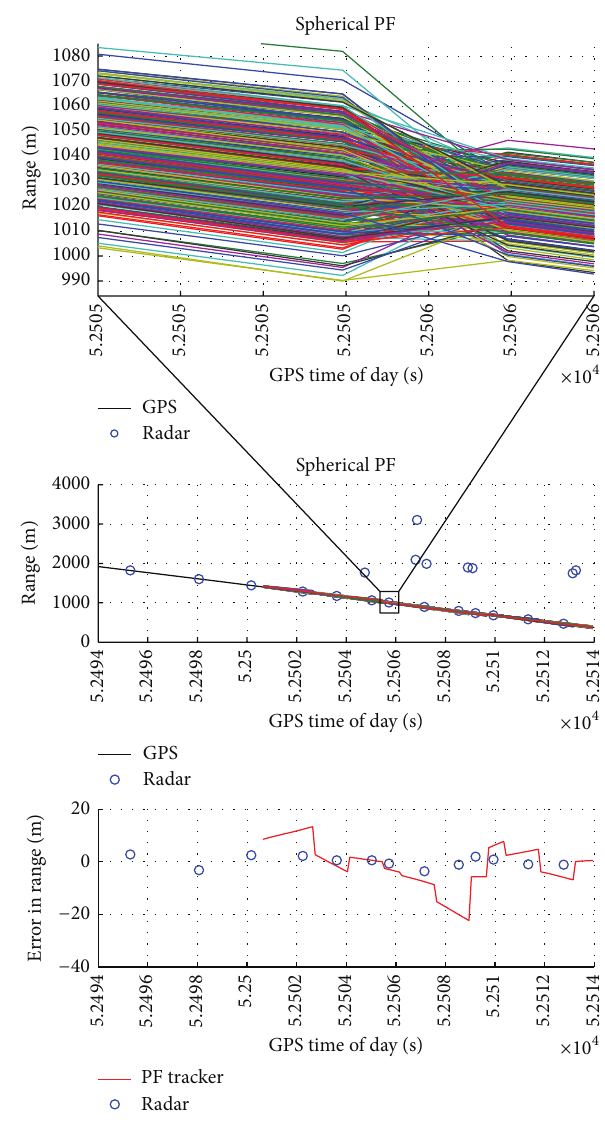
Figure 5: Range as estimated by GPS, by radar, and by radar-only tracker and estimation error as a function of GPS time of day. The upper figure highlights the trajectory of each